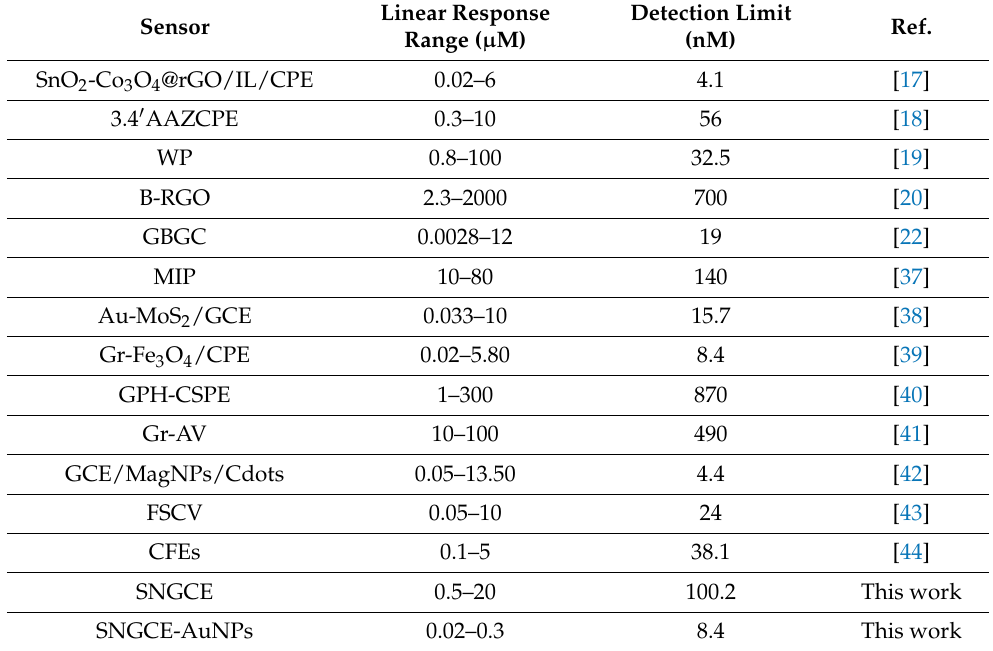
Table 1. Comparison of the analytical performance of SNGCE/AuNPs with other electrochemical